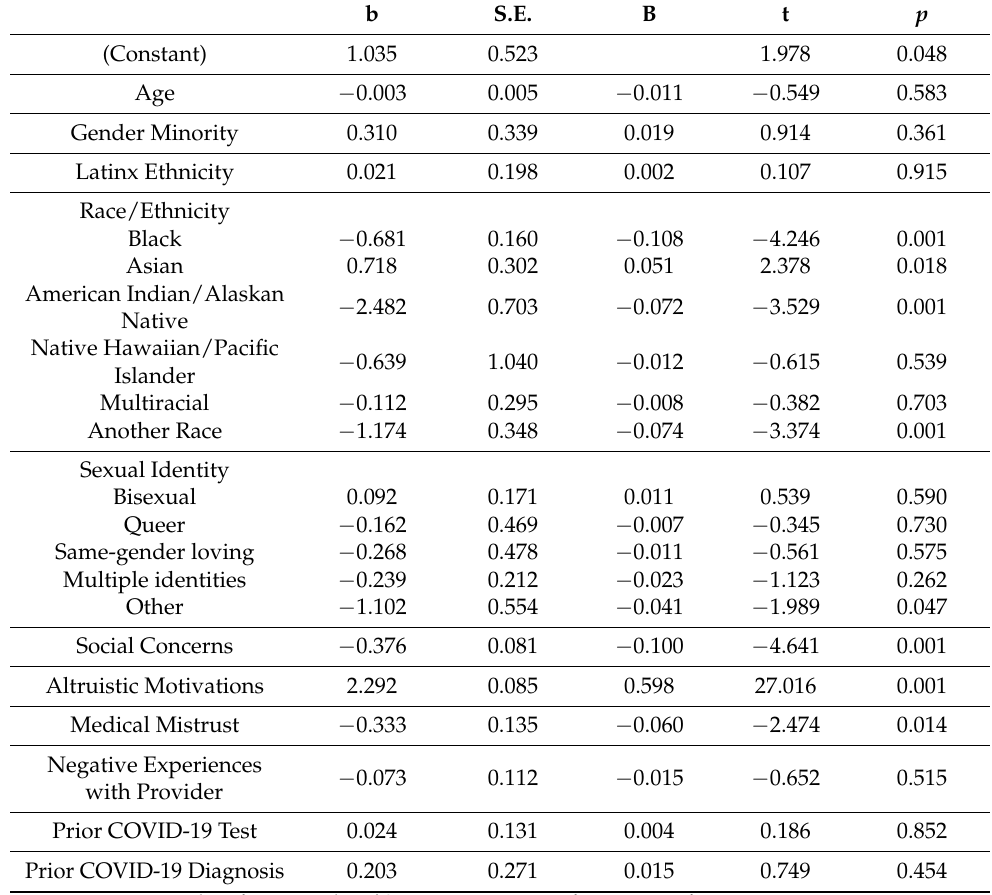
Table 2. Multivariable linear regression model examining psychosocial correlates of COVID-19 vaccine acceptance among sexual gender minority participants, N =